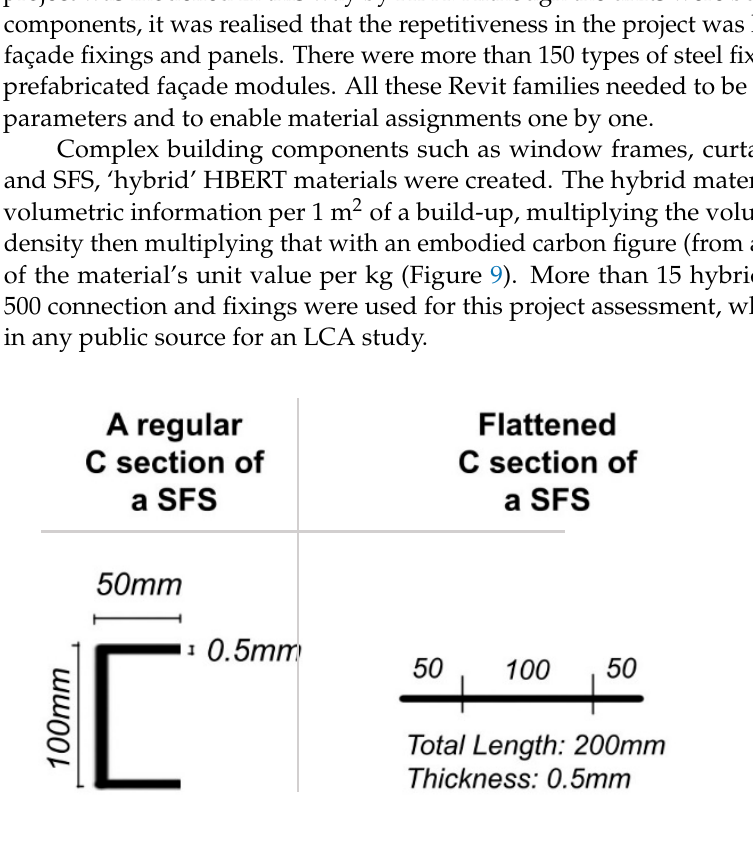
Figure 9. Example of a volume calculation for hybrid method.